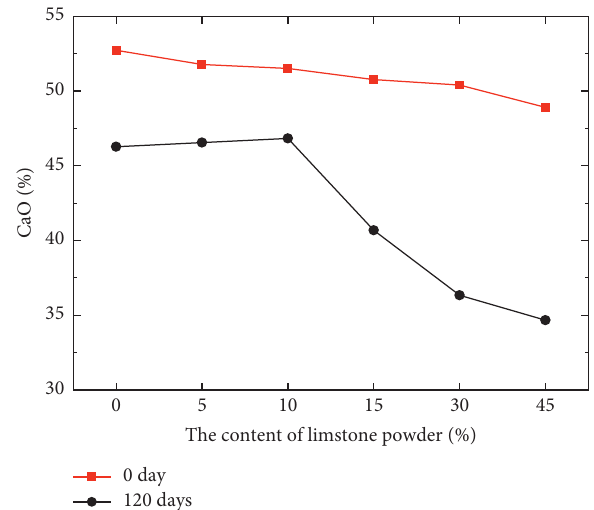
Figure 16: CaO content of the cathode surface in all samples at 120